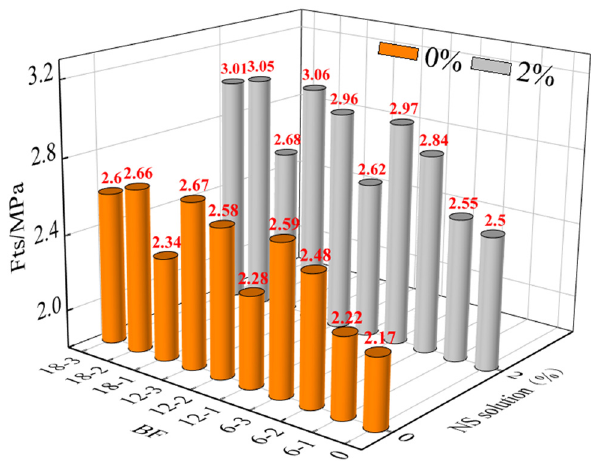
Figure 12: The synergistic e ff ect of NS and BF on the splitting tensile strength of RAC.